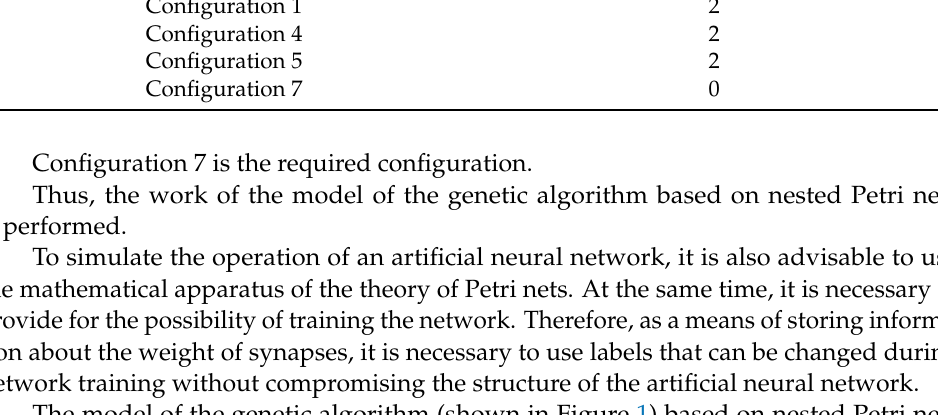
Table 8. Population after reduction.